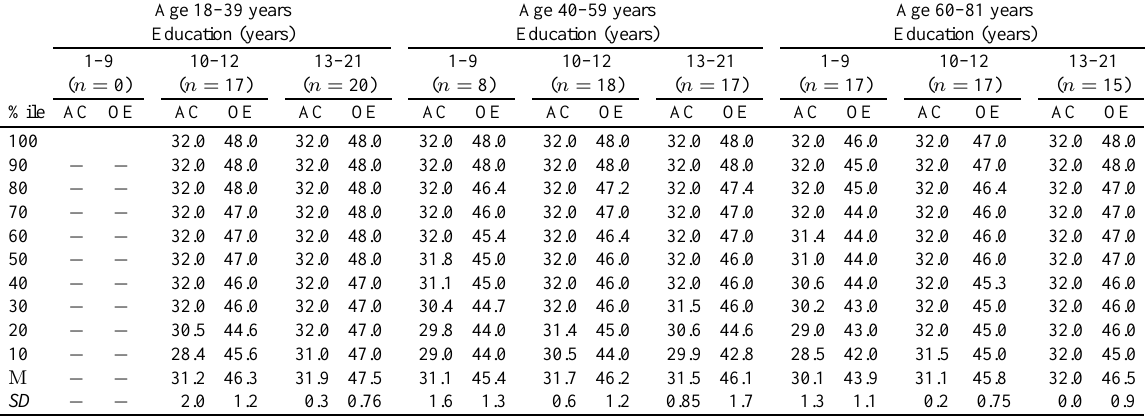
Table 5 Normative data for auditory comprehension (AC) and oral expression (OE) stratified by age and education